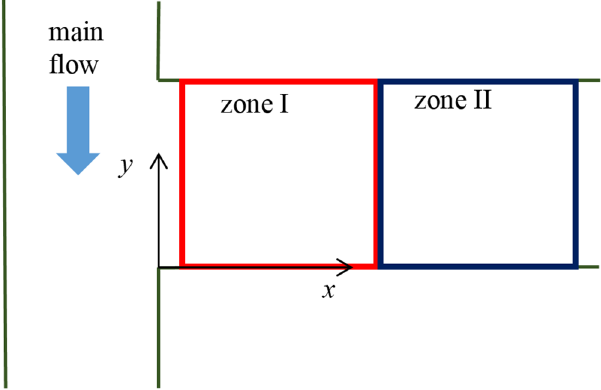
Fig. 1. Schematics of the channel.